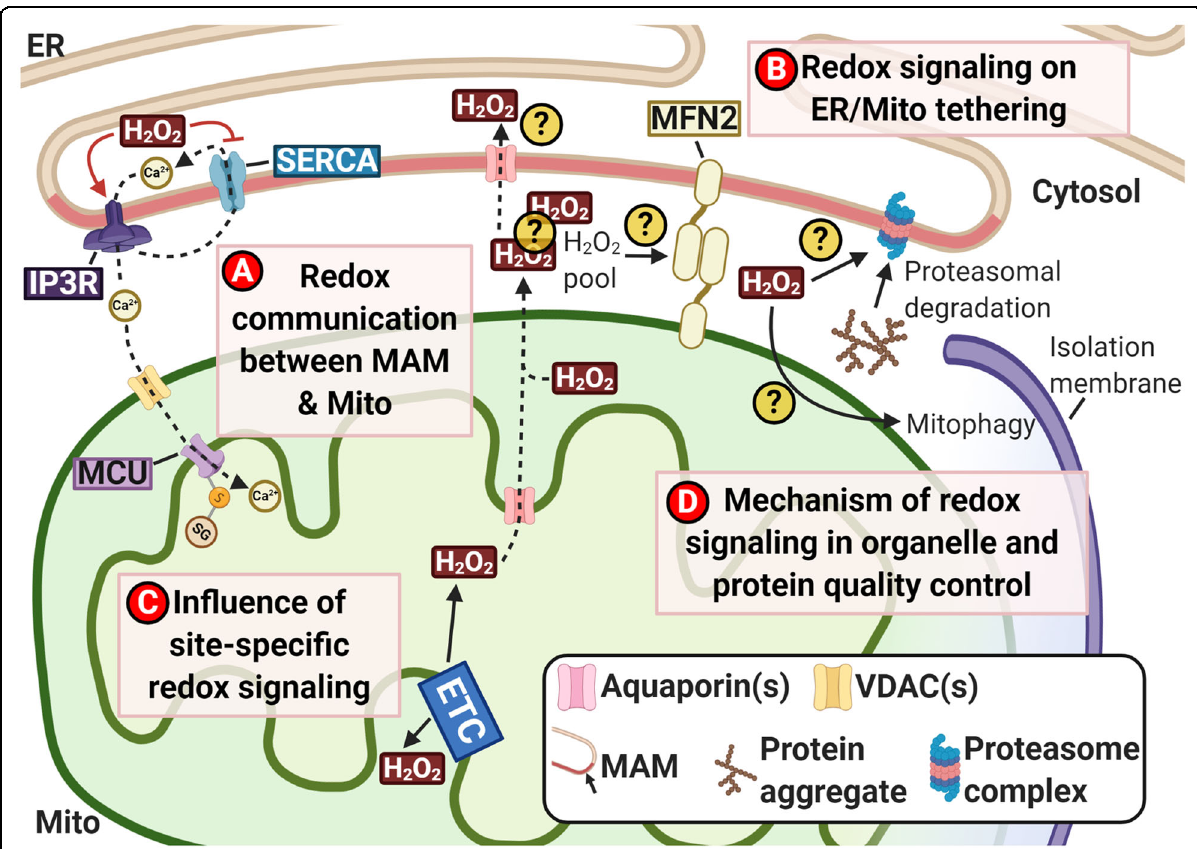
Fig. 4 The overview schematics and future directions of the importance of redox communication in the cell leading to pathogenesis of neurodegenerative diseases. A Investigate how the dysregulation of redox-regulated calcium (Ca 2 + ) signaling between the endoplasmic reticulum (ER) and the mitochondria (Mito) could contribute to the pathogenesis of neurodegenerative diseases; MAM: mitochondria-associated membrane. B Understand how the release of redox signals such as mitochondrial hydrogen peroxide (H 2 O 2 ) into the MAM-mitochondrial interface could affect ER-mitochondria tethering and dysregulate mitochondrial dynamics that could contribute to the pathogenesis of neurodegenerative diseases. C Understand how site-speci fi c redox signaling in the mitochondria could be mediated by the levels of intracellular ROS and determine the presence of H 2 O 2 pool that can act as a reservoir of secondary messengers to trigger different signaling pathways throughout the whole cells. D Identify the underlying redox regulation of mitochondrial quality control and its signi fi cance to the pathogenesis of neurodegenerative diseases. Created with